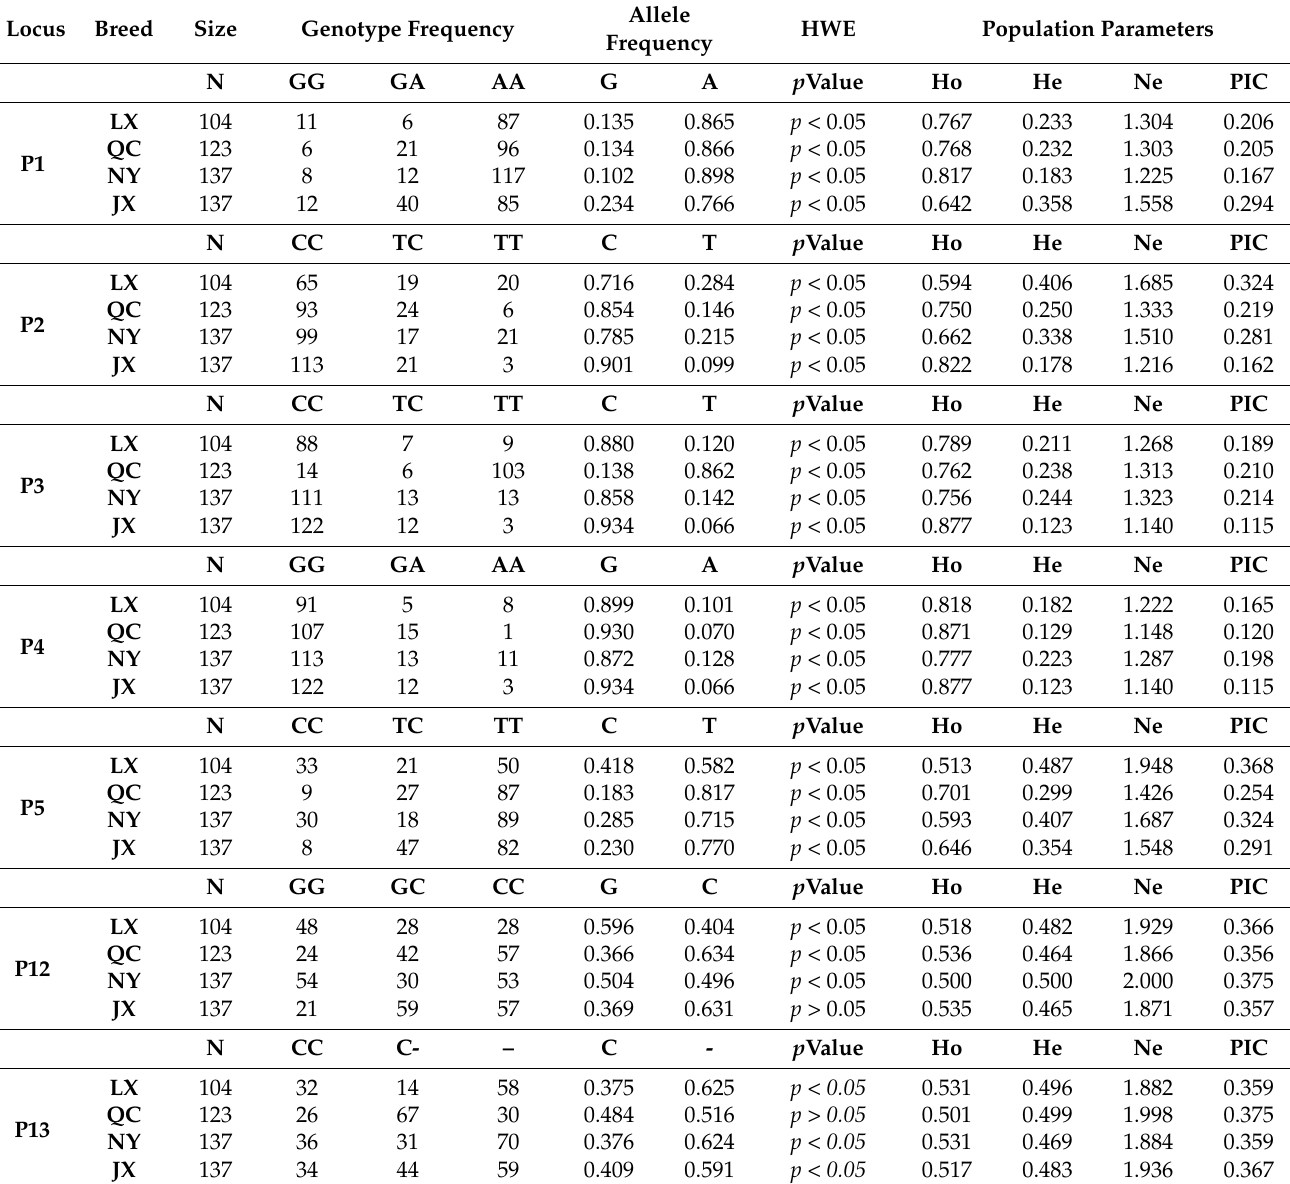
Table 3. Genotypes, alleles, He, Ne, and PIC for variations of the 14th intron, 15th exon, and downstream region in cattle PSAP.